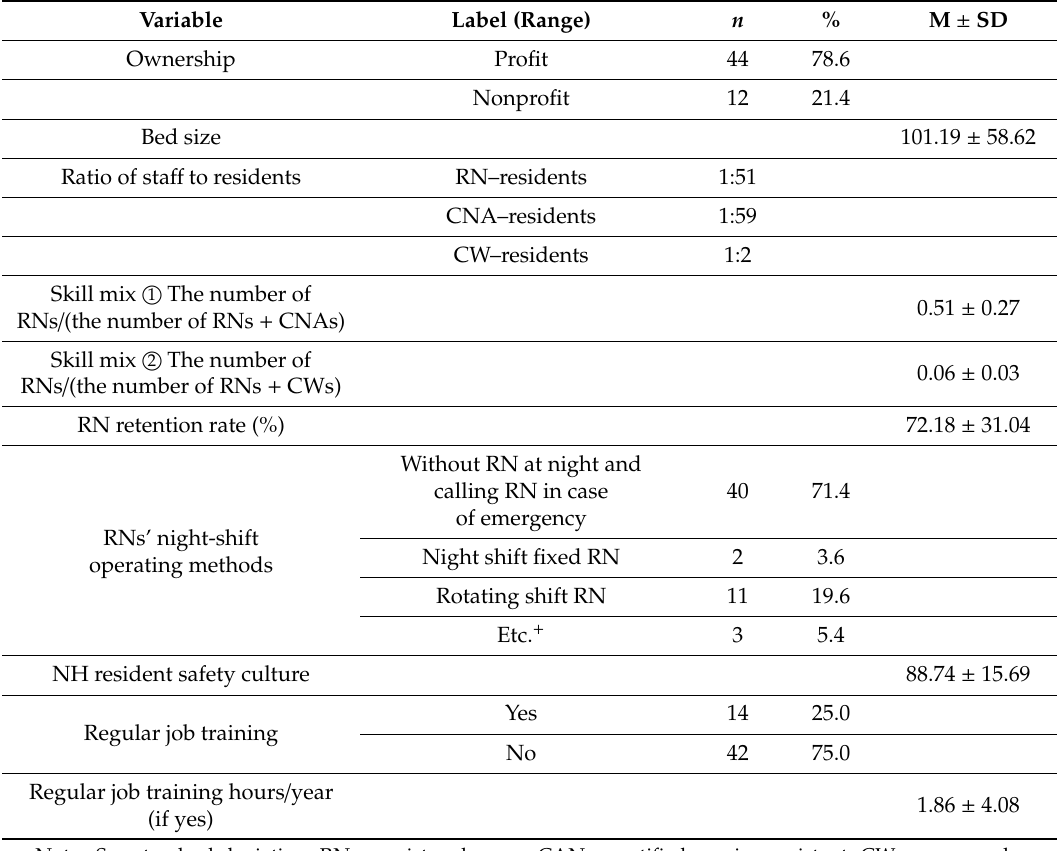
Table 2. Descriptive statistics for organizational (nursing home (NH))-level